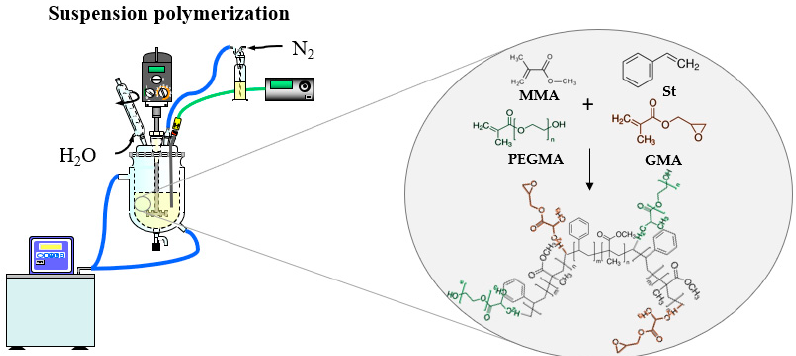
Figure 1. Schematic of the synthesis of functionalized particles.